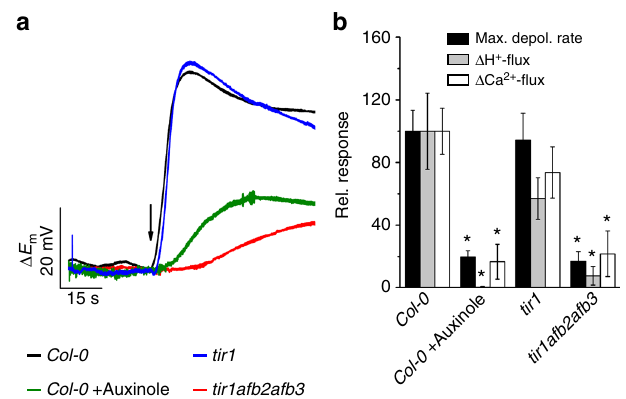
Fig. 4 The auxin-induced plasma membrane depolarization as well as H + - and Ca 2 + -in fl ux are dependent on intracellular auxin perception. a IAA- dependent changes in the membrane potential of wild-type and receptor mutant root hairs. Representative traces of A . thaliana Col-0 in the presence (green) and absence (black) of 20 µ M auxinole as well as of the tir1-1 (blue) and tir1-1afb2-3afb3-4 (red) mutants following a 1 s stimulation with 10 µ M IAA (arrow). b Maximal depolarization rate (black bars) and initial change of H + - (gray bars) and Ca 2 + - fl ux (open bars), evoked by 10 µ M IAA in roots of Col-0 ( n = 14 ± s.e.m. for depolarization; n = 10 ± s.e.m. for ion fl uxes), Col-0 pretreated with 20 µ M auxinole ( n = 6 ± s.e.m. for depolarization; n = 4 ± s.e.m. for ion fl uxes), as well as in tir1-1 ( n = 8 ± s.e.m. for depolarization; n = 16 ± s.e.m. for ion fl uxes) and in tir1-1afb2-3afb3-4 ( n = 6 ± s.e.m. for depolarization; n = 9 ± s.e.m. for ion fl uxes). Values are given as the percentage of the wild-type response. Asterisks indicate signi fi cant reductions (Students t -test, p <